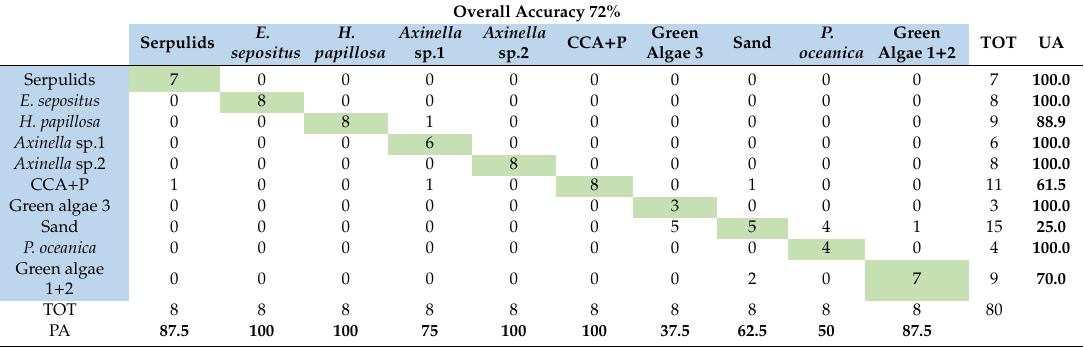
Table 4. Confusion Matrix for the coralligenous site